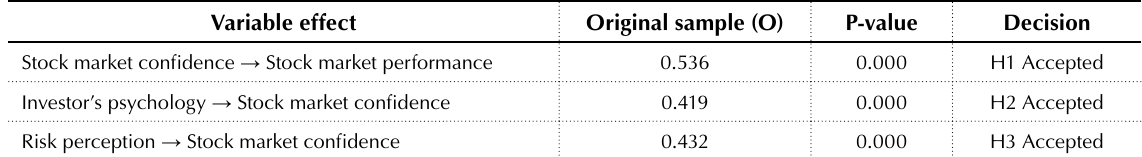
Table 11. The result of hypotheses research